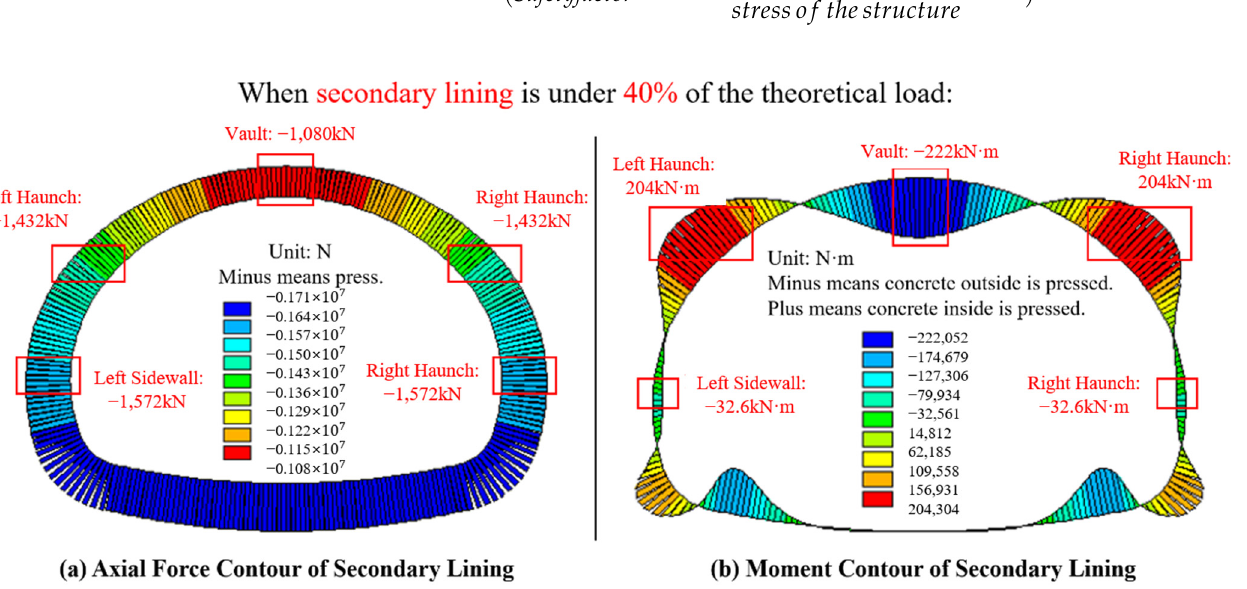
Figure 10. Measured and simulated vault settlement. When primary support is under 40% of the theoretical load, the result of simulation is in accord with the measurement.